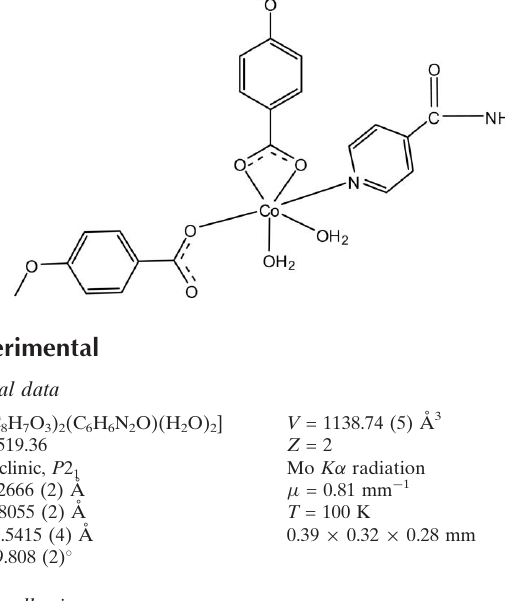
Data collection Bruker Kappa APEXII CCD area- detector diffractometer Absorption correction: multi-scan ( SADABS ; Bruker, 2005)